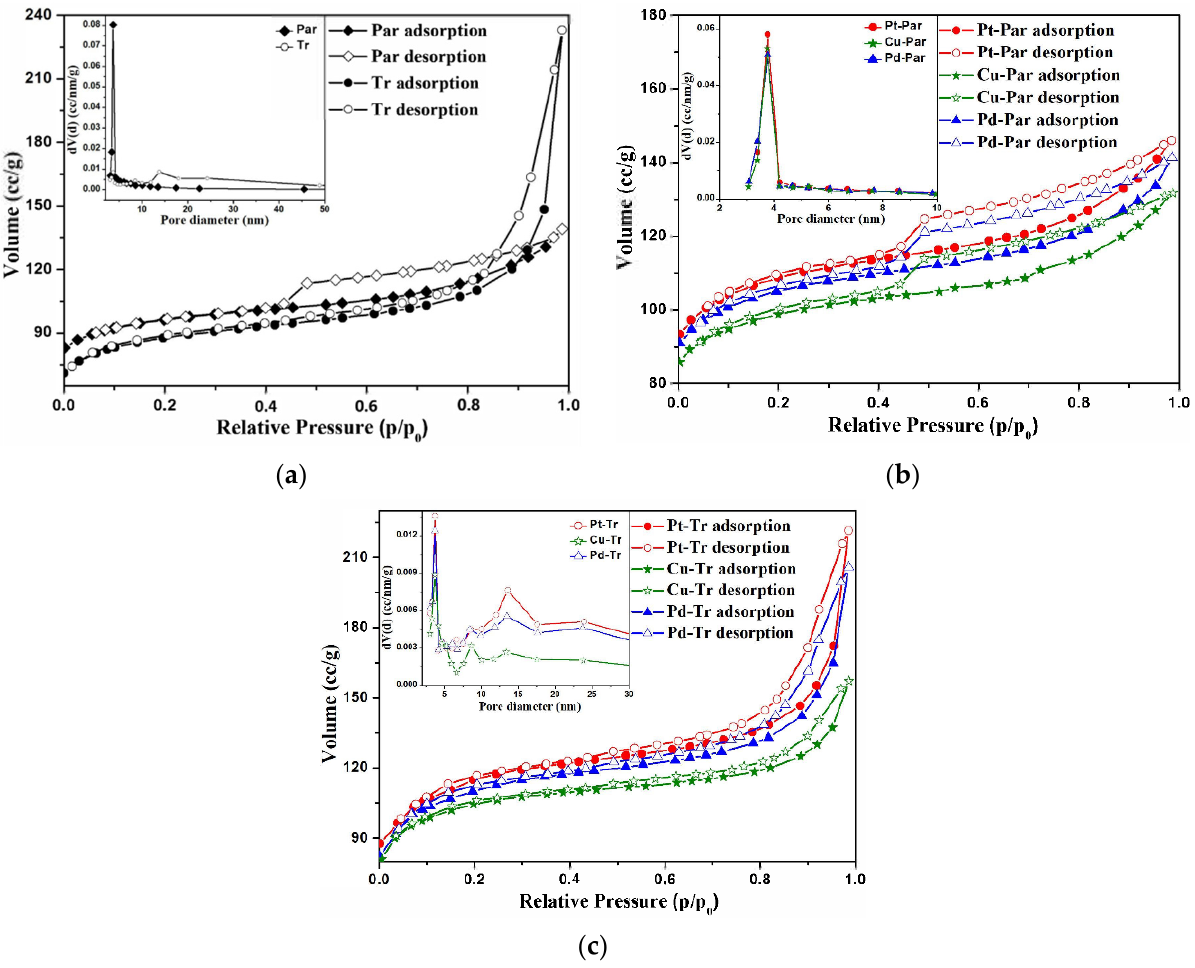
Figure 2. Nitrogen adsorption/desorption isotherms of ( a ) parent and treated; ( b ) parent impregnated with Pt, Cu, and Pd; and ( c ) treated impregnated with Pt, Cu, and Pd. Inset—corresponding pore size